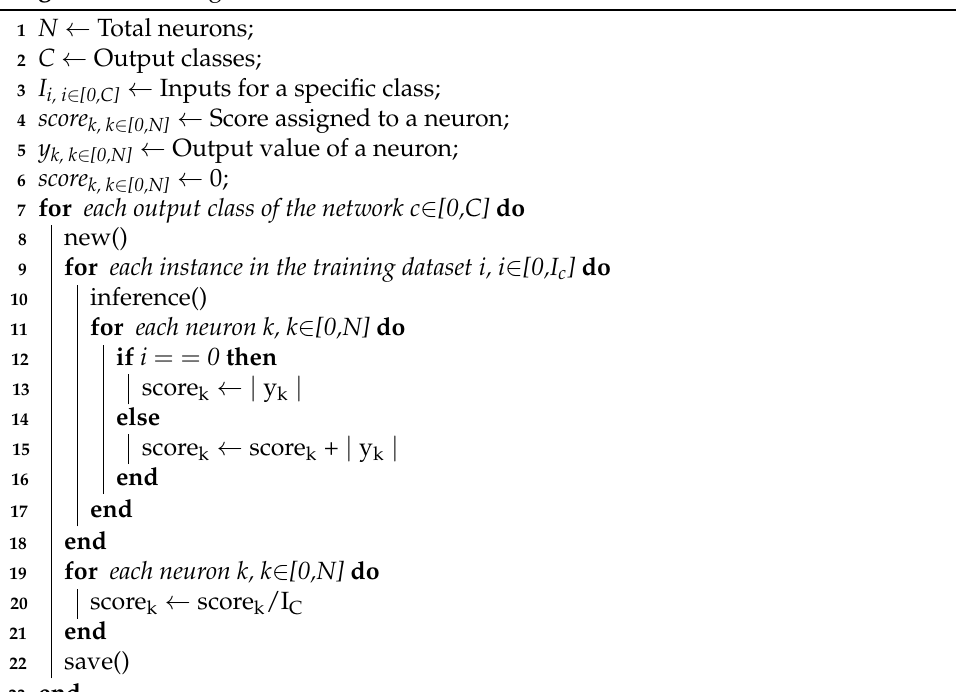
Algorithm 1: Assignment of resilience scores to individual